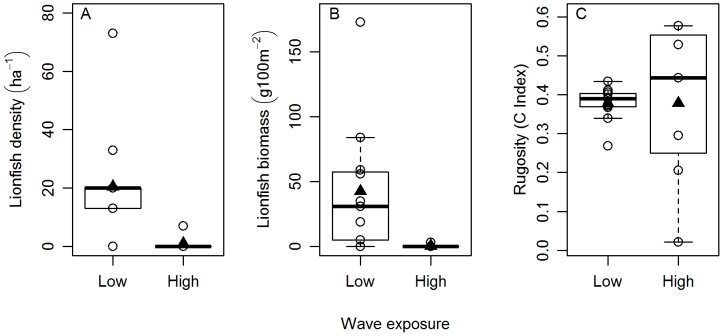
Effect of wave exposure (low/high) on lionfish abundance (density or biomass) and rugosity.Box plot of the relationships between wave exposure (categorized as low or high) and (A) lionfish density (individuals ha−1), (B) lionfish biomass (g 100 m−2), and (C) reef rugosity (C Index). Triangles denote mean values and open circles represent the mean value on each study site.